Question: In a single sentence, describe what this figure presents.
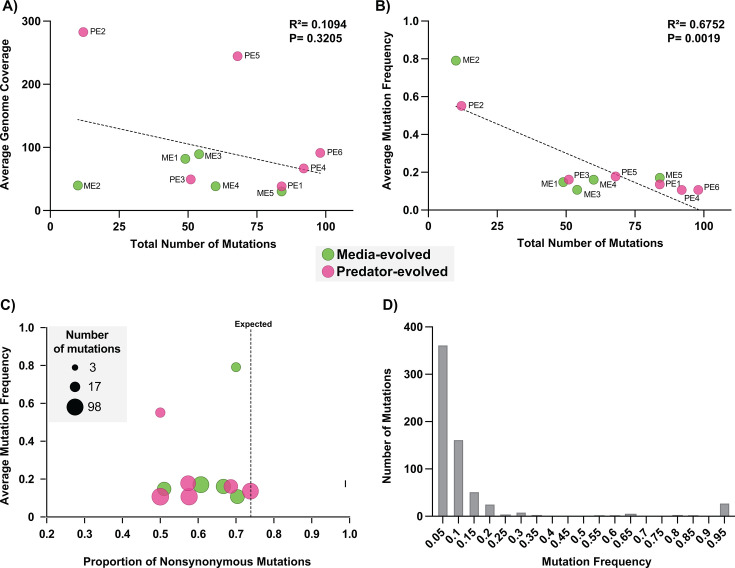
Answer: Mutations (≥0.5 frequency) detected in evolved populations. ( A ) Relationship between average mutation frequency and the total number of mutations per evolved population. ( B ) Relationship between average genome coverage and the total number of mutations per evolved population. For panels A and B , R ² values and P values were calculated using simple linear regression. ( C ) Mutation frequency and proportion of nonsynonymous mutations across evolved populations. Scatter plots show the average mutation frequency ( y -axis) versus the proportion of nonsynonymous and nonsense mutations ( x -axis) for each evolved population at D60. Circle size represents the total number of mutations detected per population. The vertical dashed line represents the number of nonsynonymous (including nonsense) mutations expected by random chance. ( D ) Number of mutations detected at different frequencies between 0.5 and 1 across all evolved populations. Each bar represents the lower bound of each 0.05 interval (e.g., 0.05 = 0.05–0.09; 0.95 = 0.95–1.0).